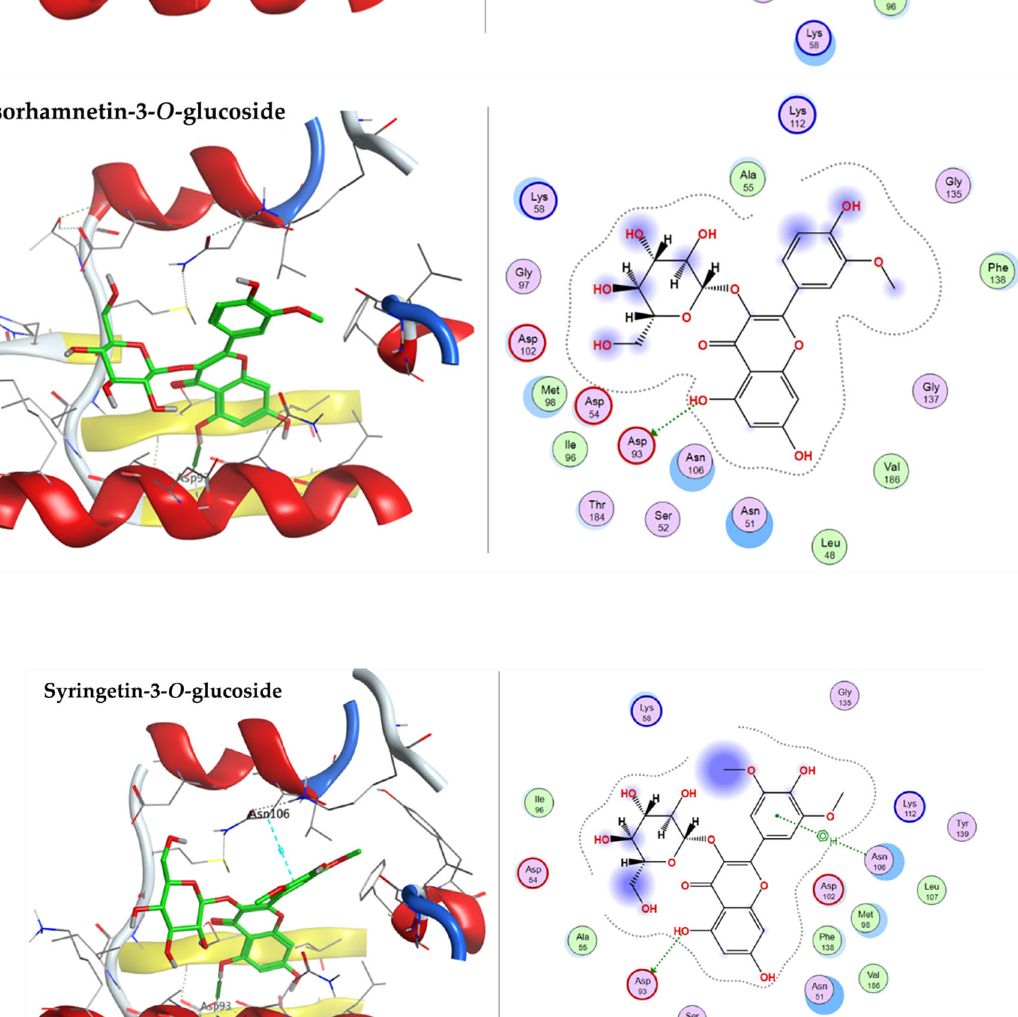
bustaflavone 7,4’ ‐ dimethyl ether, and ferulic acid on epidermal growth factor receptor (EGFR) tyrosine kinase (PDB code: 1M17) reached the binding site of the enzyme. In com ‐ parison to the co ‐ crystallized ligand (AQ4: erlotinib), the docked components showed a good binding affinity, where the docking energy score ranged from − 9.0112 to − 5.1249 kcal/mol. The components confirmation within the active pocket stabilized by the H ‐ bond interaction with the crucial amino acid residues. Table 4 shows the detailed amino acid residues involved in the interactions with the docked components. One of hydroxyl group of narcissoside (isorhamnetin ‐ 3 ‐ O ‐ rutinoside), isorhamnetin ‐ 3 ‐ O ‐ glucoside, and syrin ‐ getin ‐ 3 ‐ O ‐ glucoside acts as an anchor, forming an H ‐ bond interaction with acidic ASP831. This is allowed the rest of the component structure to fill the active site properly, forming more H ‐ bond interactions with MET742, GLN767, and MET769 in addition to a pi ‐ H bind interaction with LEU694 (Figure 9). Table 4. Docking details of the selected components of ARBE on EGFR. Component